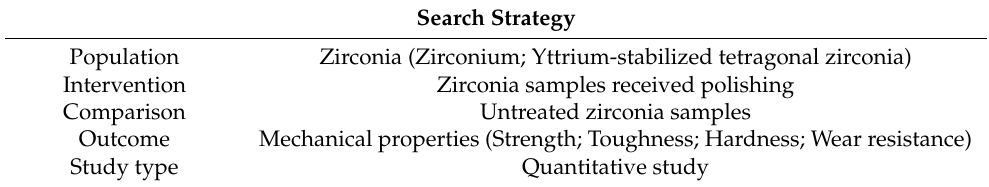
Table 1. Systematic search